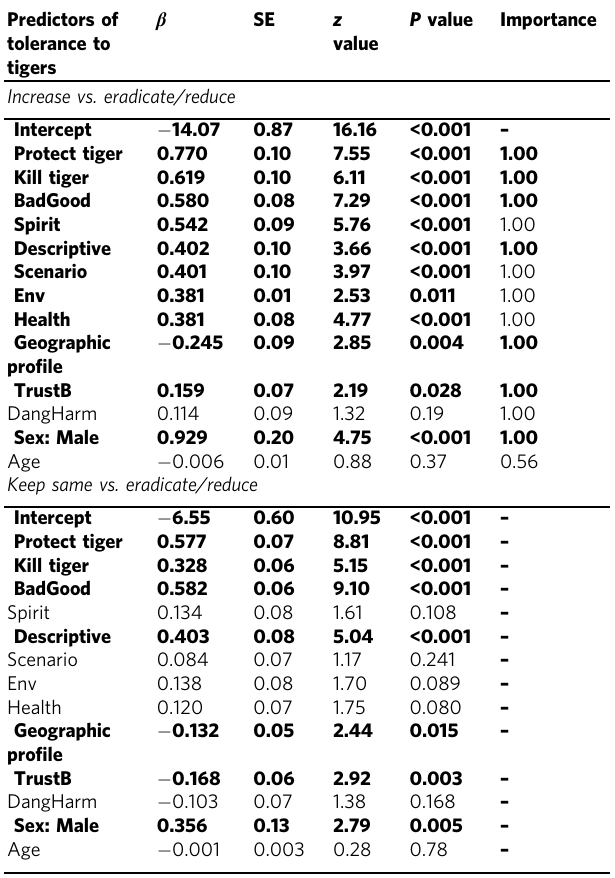
Table 2 Multinomial logistic regression model describing predictors of people ’ s tolerance to tigers Predictors of tolerance to